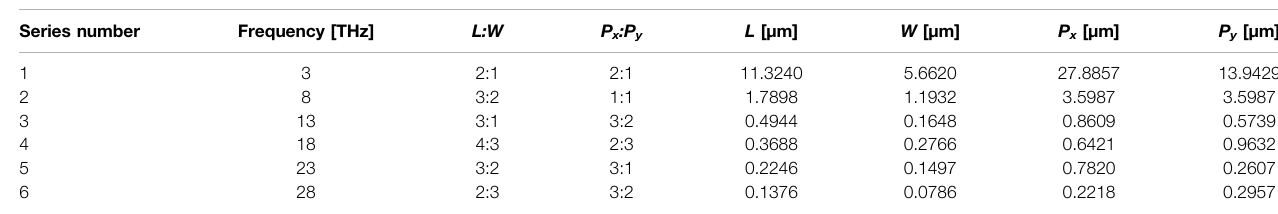
TABLE 4 | Geometrical parameters for GCWA associated with Figure 4C